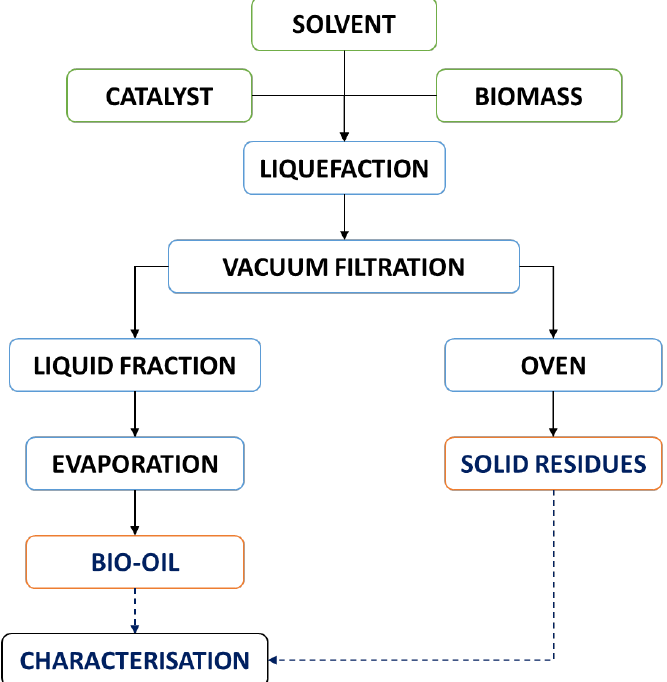
Figure 2. Liquefaction process flowchart of the pinewood samples.